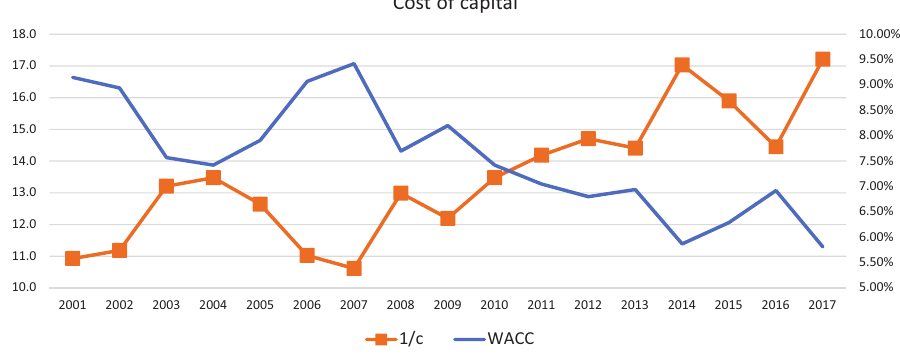
Figure 2. Cost of capital variation (source: own